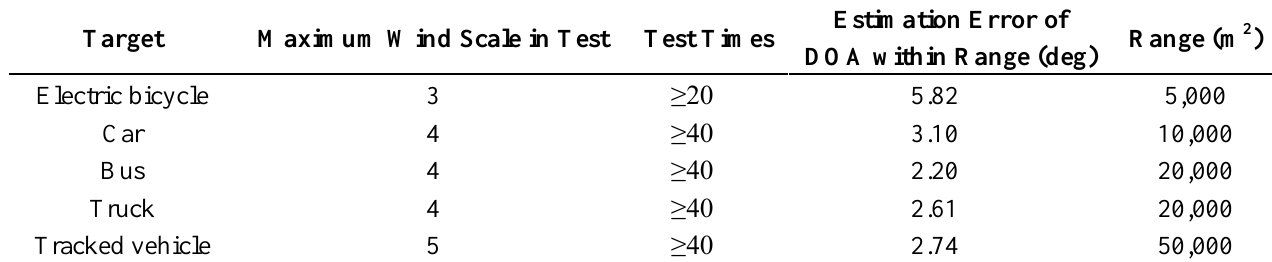
Table 3. Experimental results.